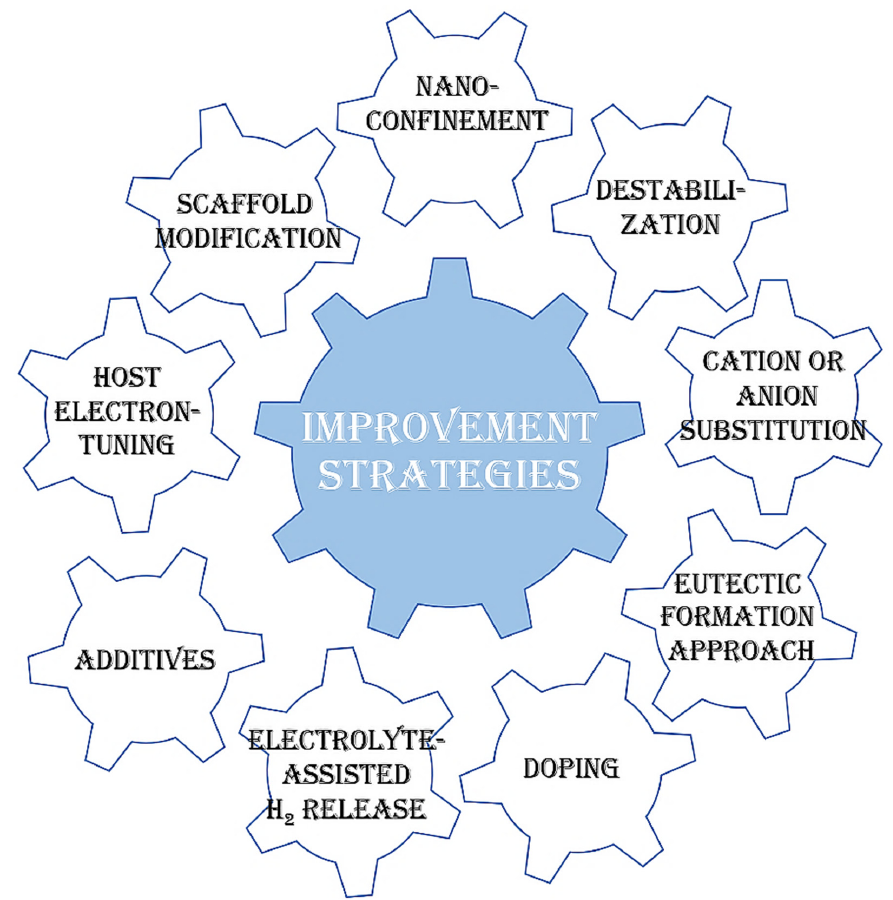
Figure 20. Improvement avenues that were explored to enhance hydrogenation effectiveness in hy- dride-based